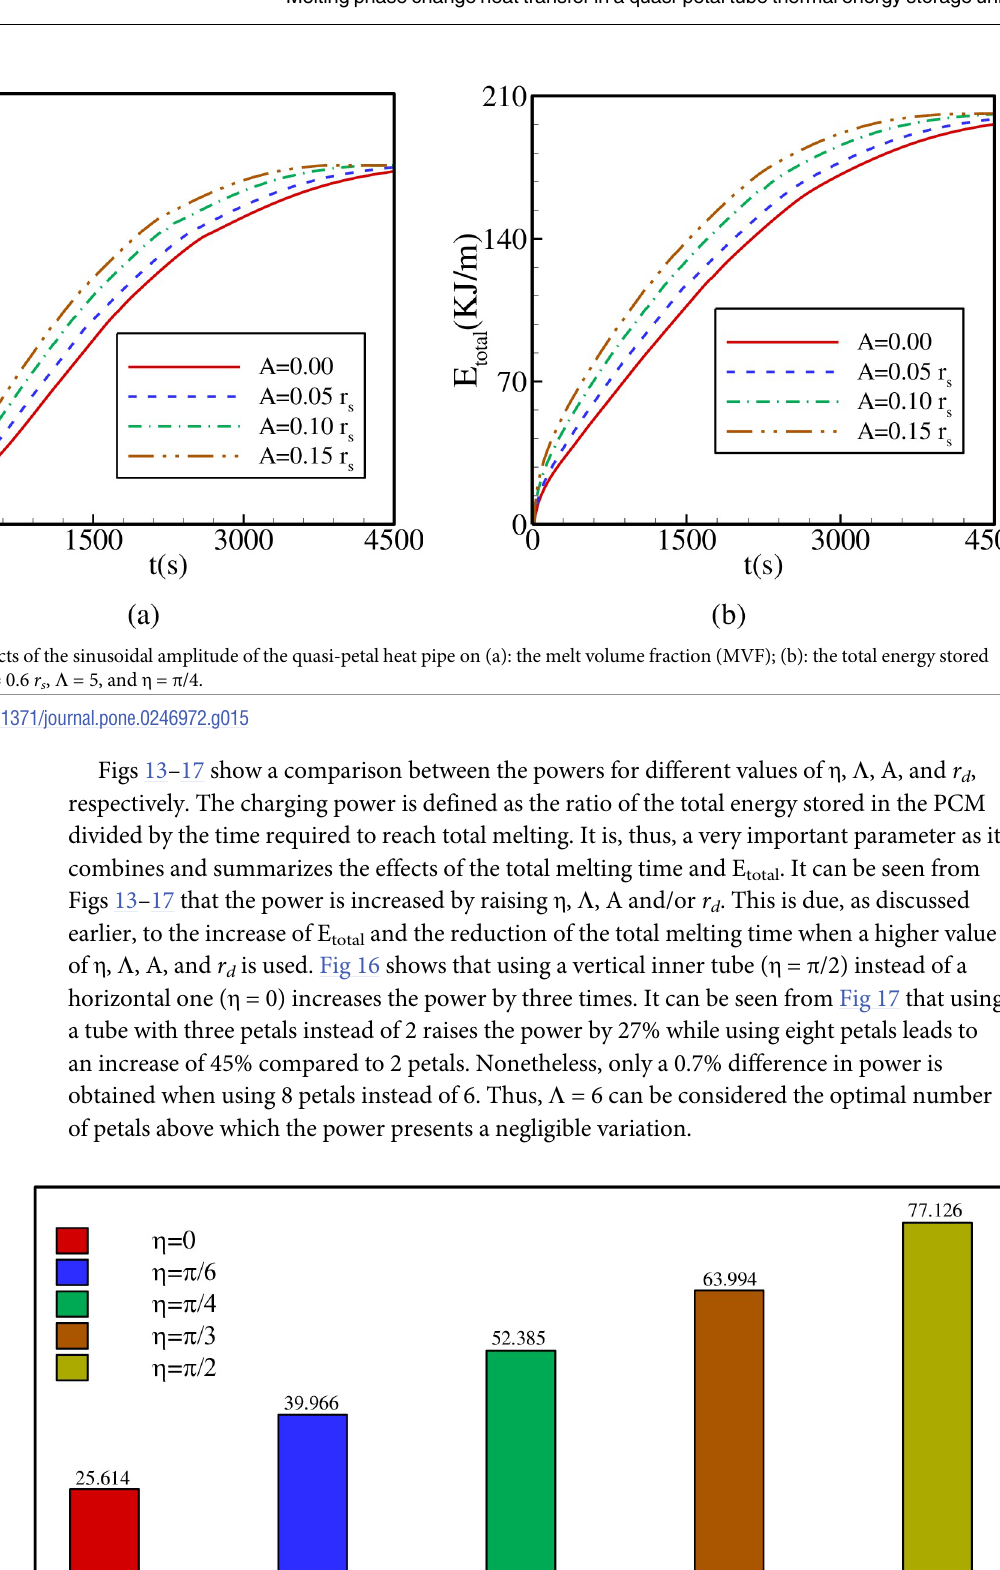
= 0.6 r , A = 0.15 r d s